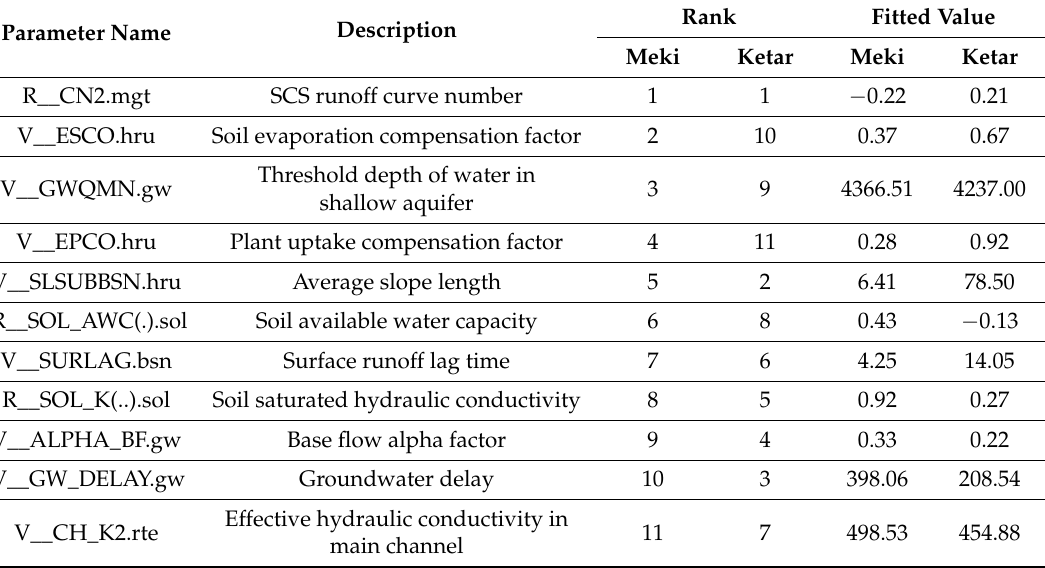
Table 2. Sensitivity rank of hydrological parameters for model